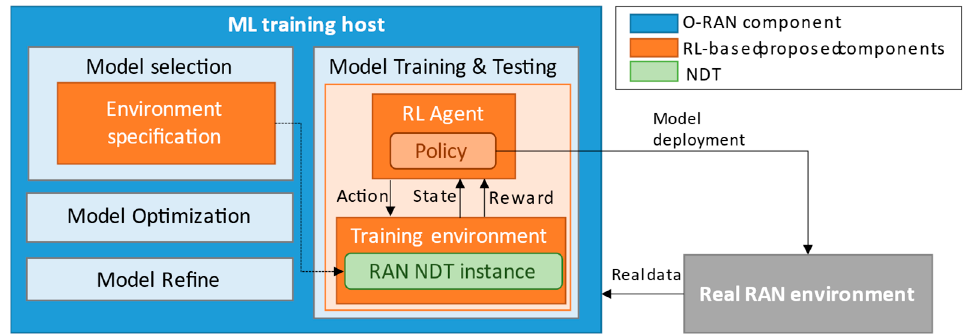
Figure 2. Functional model of the RL model training process on NDT. The training is performed on the ML training host that includes different functionalities identified in the O-RAN ML workflow.